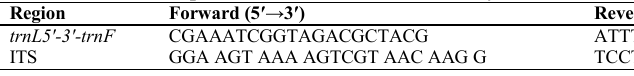
Table 3 . Primer sequences were used in this study. Region Forward (5′→3′) Reverse (5′→3′) ITS White et al .